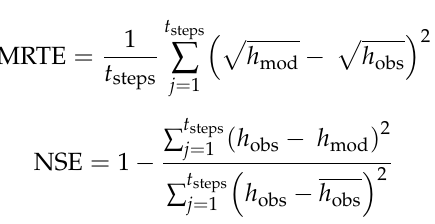
Figure 6. Rank histograms for the tested accumulation ( 𝑇 1 ) and downscaling ( 𝑇 2 ) combinations in the UK case study.